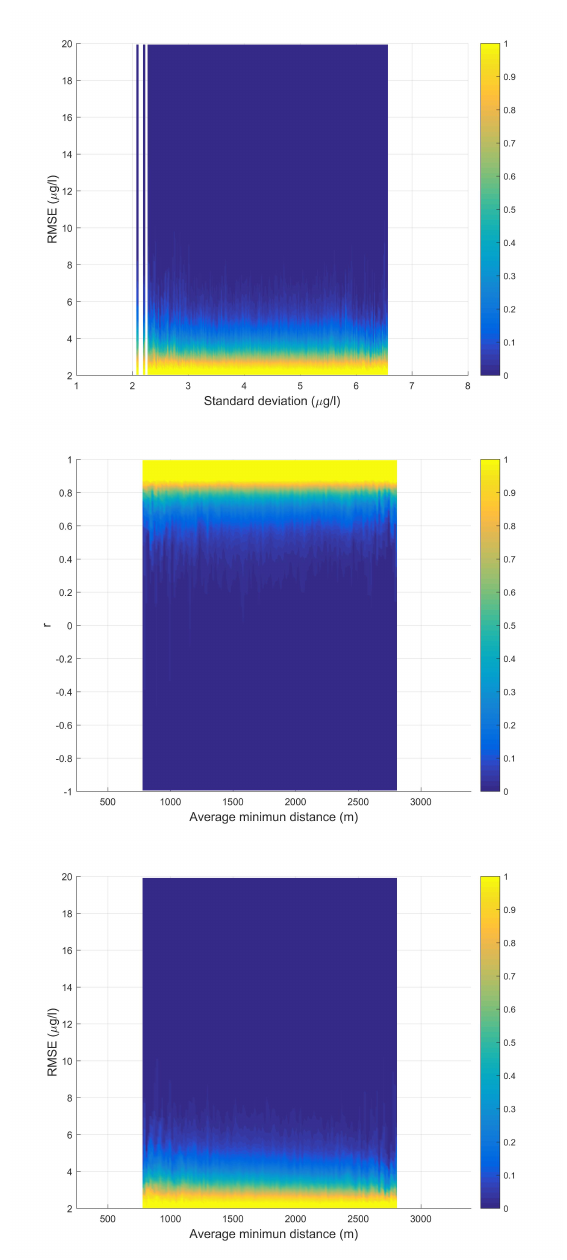
Figure 5. Cumulative probability histograms derived using 5 bands and 12 randomly selected reference samples. The standard deviation bins (top) or average minimum distance bins (middle and bottom) for which the sum of counts is below 30 are rejected from probability